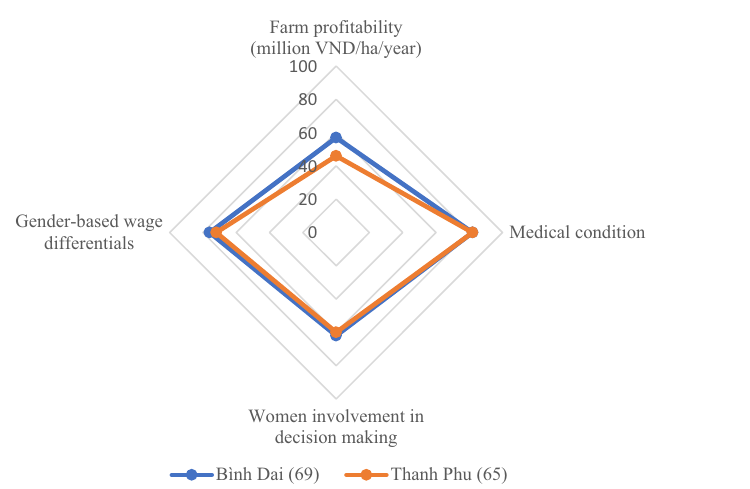
Figure 10. Equity